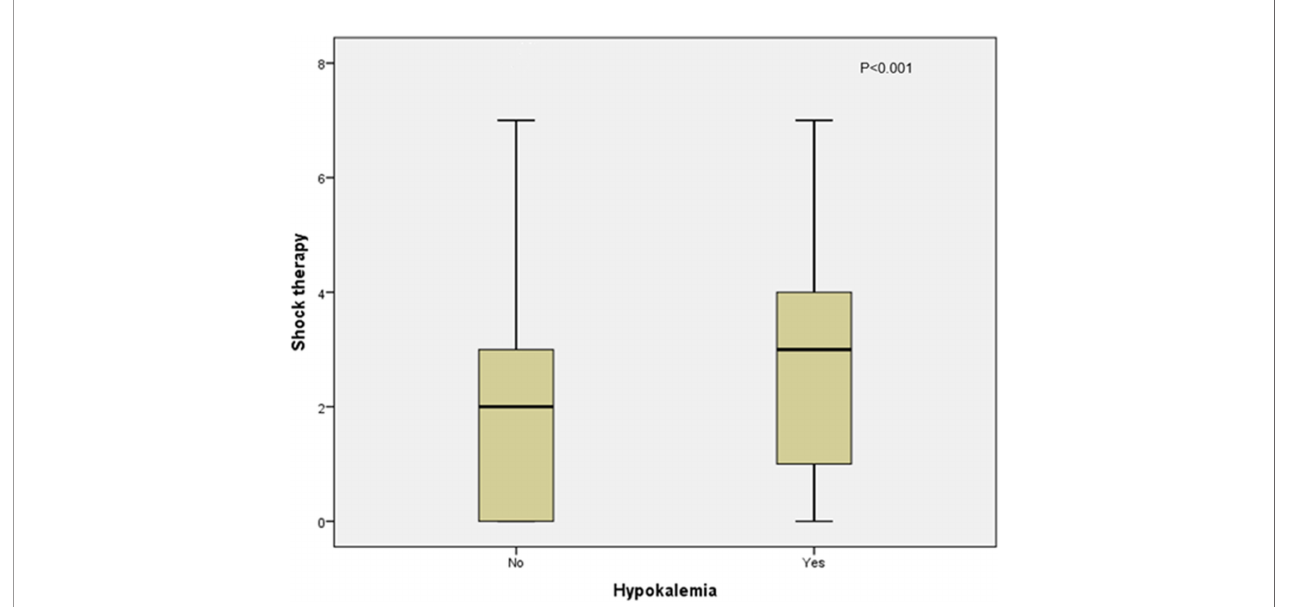
FIGURE 1 | Association between hypokalemia and the amount of shock therapy received in the second COVID-19 wave.